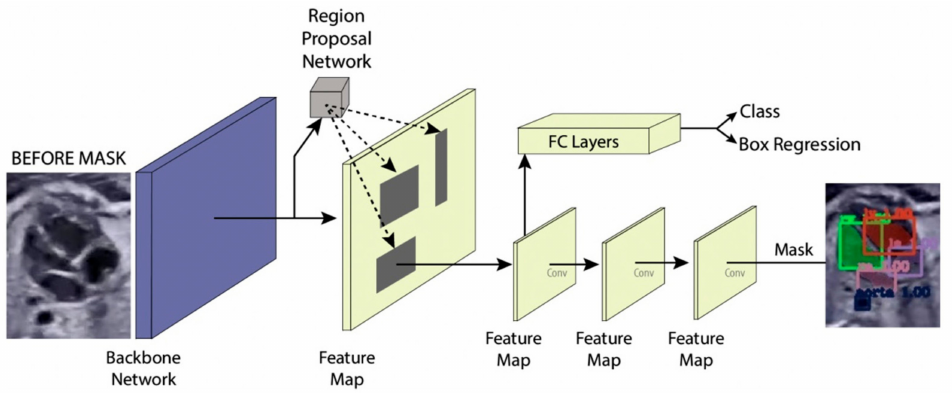
Figure 6. Instance segmentation